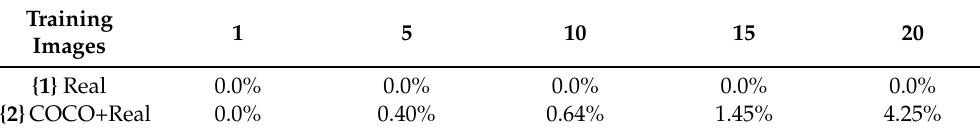
Table 2. Segm-AP50 results, comparing {1} and {2} .